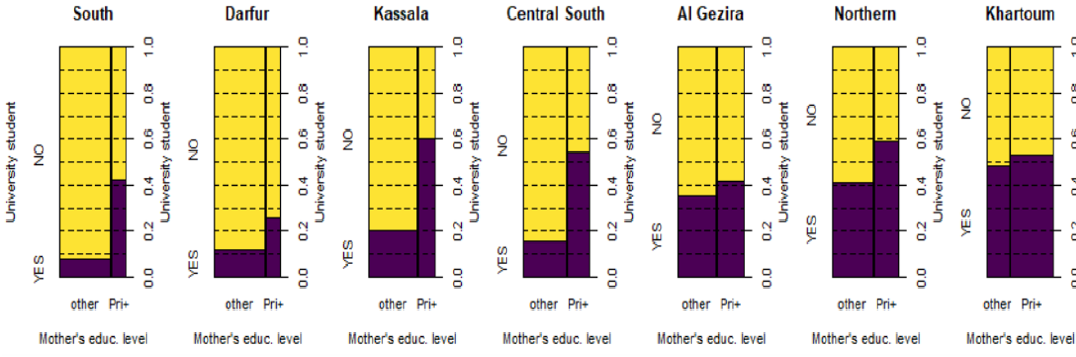
Figure 8. University attendance rates by mother’s education for 19–21-year-olds, by region.